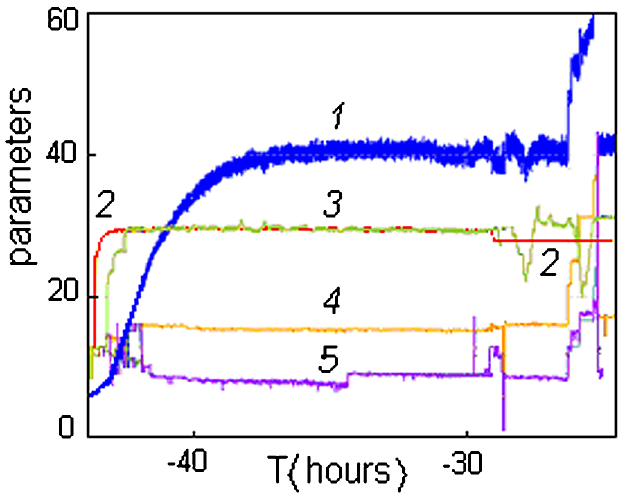
FIG. 8. Evolution of H (cid:1) beam intensity of the saddle antenna rf LV SPS; (1) ion beam current; (2) gas flow; (3) collar temperature; (4) forward rf power; (5) reflected rf power.